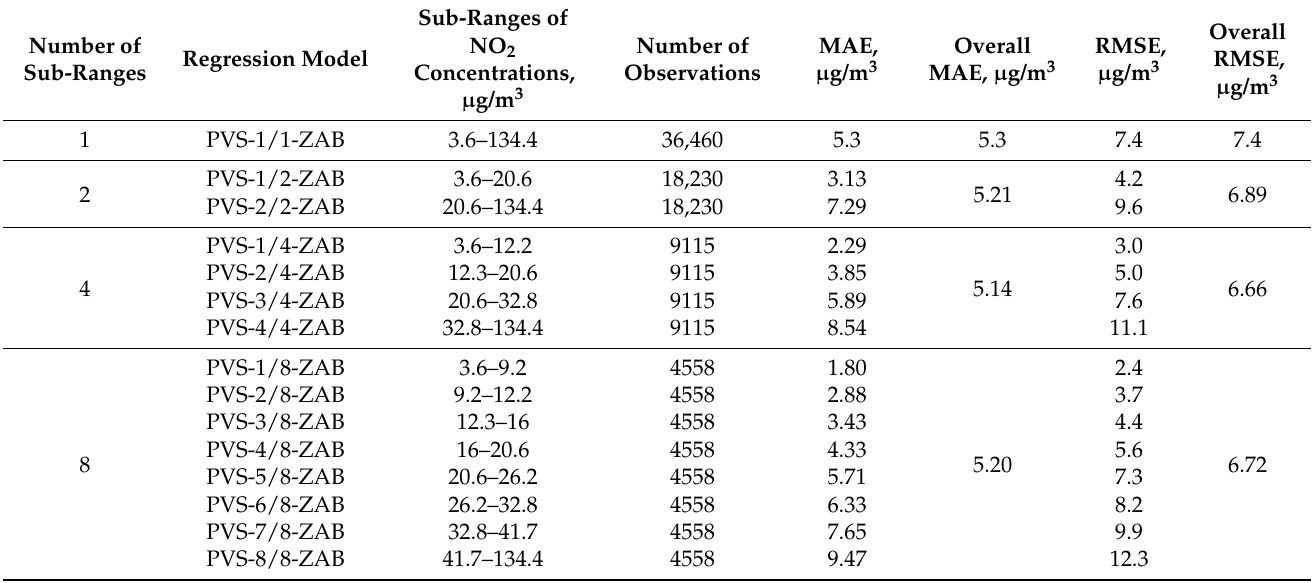
Table 11. Values of approximation errors of NO 2 concentrations in PVS models, Zabrze 2011–2016.